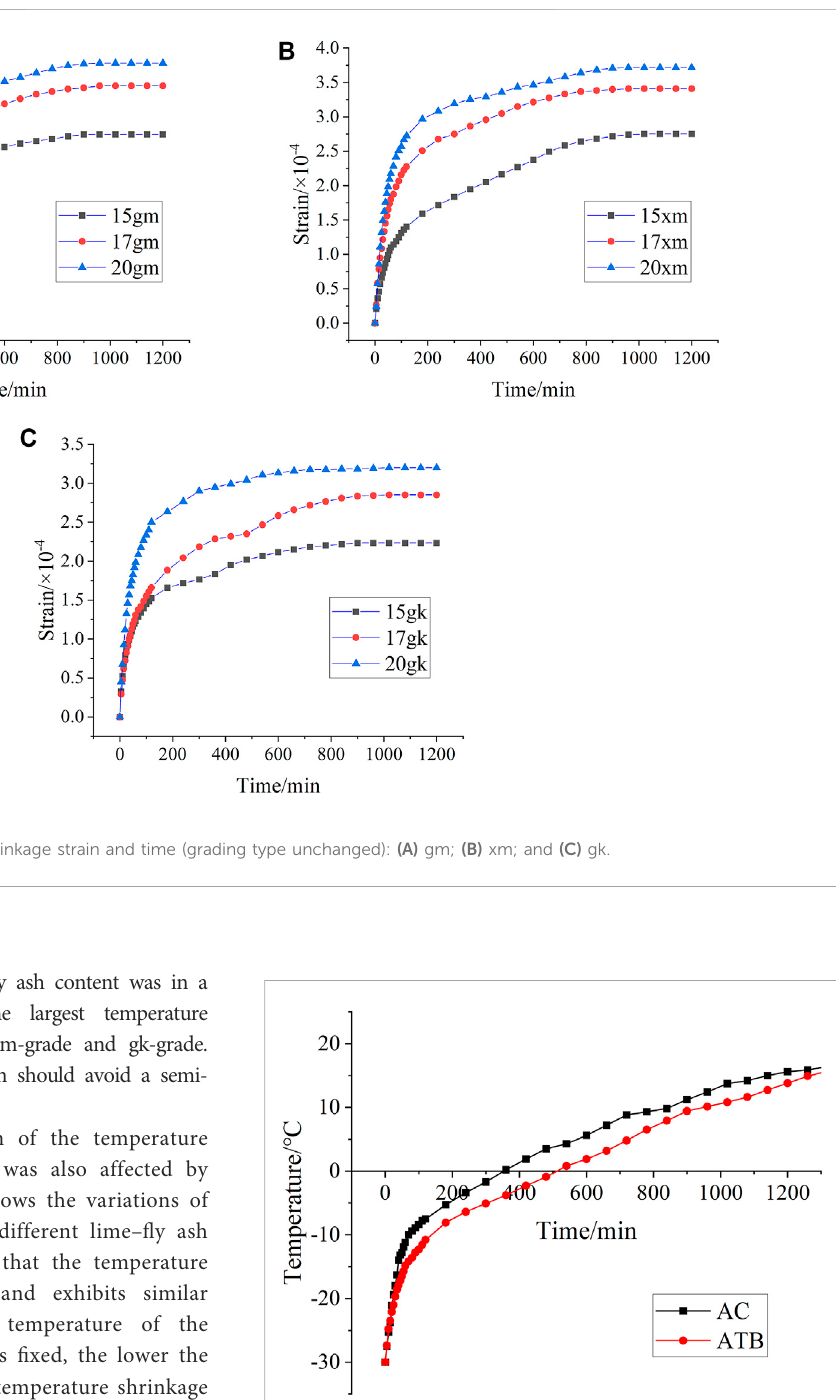
FIGURE 7 Relationship between the internal temperature and time of the asphalt